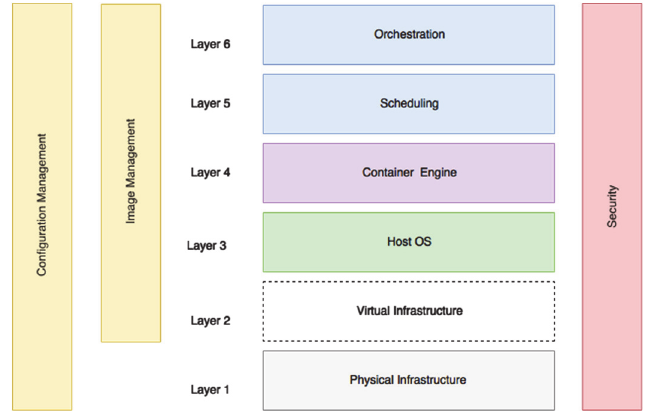
Fig. 1. Reference architecture of cloud